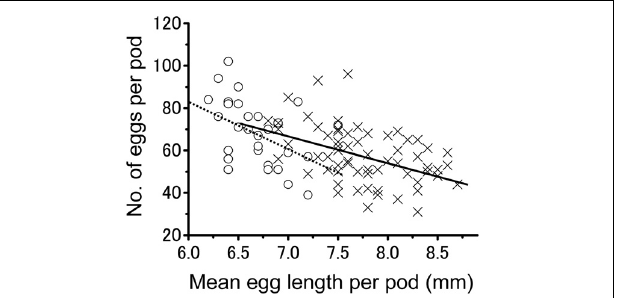
FIGURE 3 | The relationship between egg size and the number of eggs per pod laid by either the isolation-reared adults (open circles) or crowd-reared Schistocerca gregaria (crosses). A negative correlation was found for the isolated group (dotted line, r = − 0 . 466; z = − 2 . 57; n = 29; P < 0 . 01) and crowded group (solid line, r = − 0 . 444; z = − 3 . 75; n = 65; P < 0 . 001).